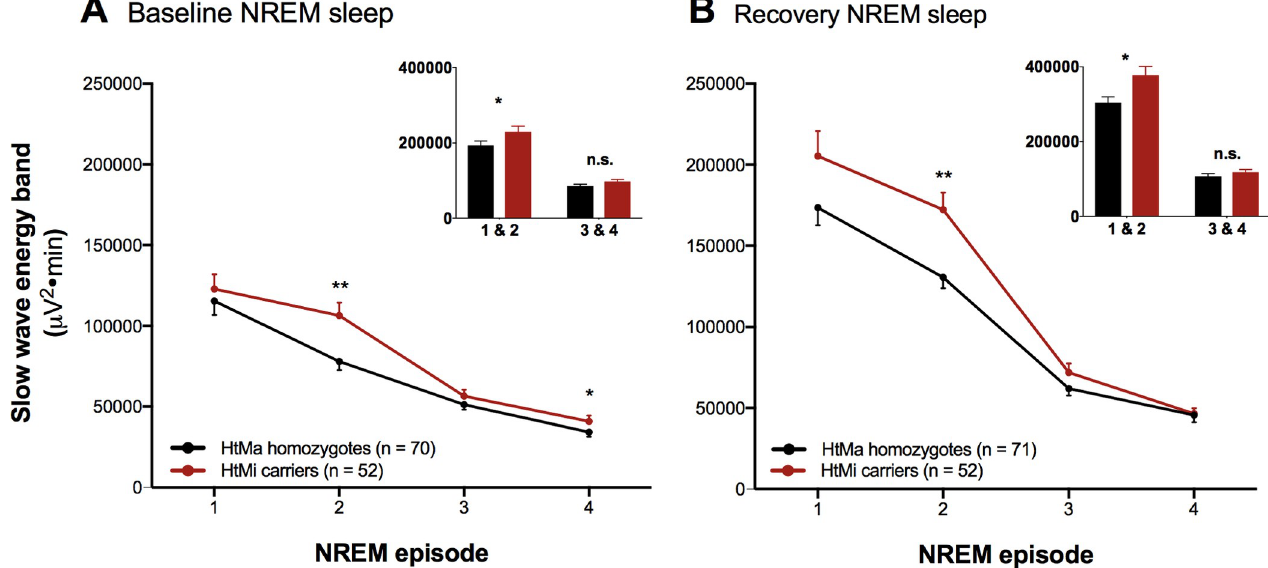
Fig 3. Time course of EEG slow wave production is associated with the AQP4 haplotype. To probe the role of AQP4 on sleep-wake regulation, SWE across the first 4 NREM episodes (A and B) was investigated. The data confirmed the previously detected overall increase in SWE in the AQP4 HtMi carriers (red) compared to the HtMa homozygote (black) group (“haplotype”: F 1,121 = 5.39; P < 0.03, η p2 = 4.26%). Moreover, a significant AQP4-haplotype modulation across the first 4 NREM episodes was observed (“haplotype x NREM episode”: F 3,843 = 2.65; P < 0.05; η p2 = 0.93%), an effect that was strongest in the second NREM episode. AQP4 HtMi carriers were found to have increased SWE mainly in the early part of the night (figure inserts). Spectral energy values of the slow wave band (0.75–4.5 Hz) in NREM sleep episodes 1 through 4 and the second part of the night (early: 1 and 2, late: 3 and 4) are plotted for the 2 haplotype groups for both baseline and recovery sleep (S3 Data). Data represent mean ± SEM. Unpaired two-tailed t tests: � P < 0.05, �� P < 0.01. AQP4, aquaporin 4; EEG, electroencephalographic; HtMa, Major allele of haplotype; HtMi, Minor allele of haplotype; NREM, non–rapid eye movement; SWE, slow wave energy.